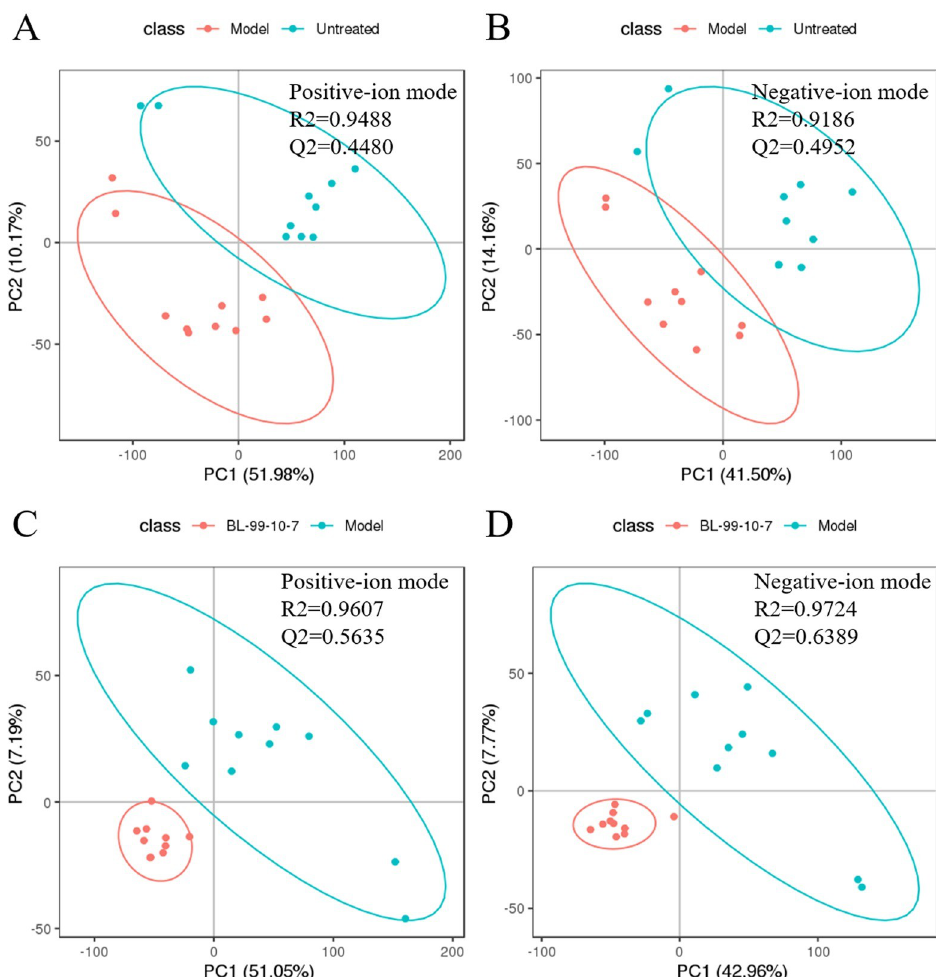
Fig 5. Partial least-squares discriminant analysis (PLS-DA) for the intestinal metabolic profiles. (A) was in the positive ion mode and (B) in negative ion mode between the intestinal functional disorder adult zebrafish (model) and normal (untreated); and (C) was in the positive ion mode and (D) in negative ion mode between the intestinal functional disorder adult zebrafish (model) and the model zebrafish treated with B . lactis BL-99 at 2.42 � 10 7 CFU/mL (BL-99-10-7). These ellipses represented the 95% confidence